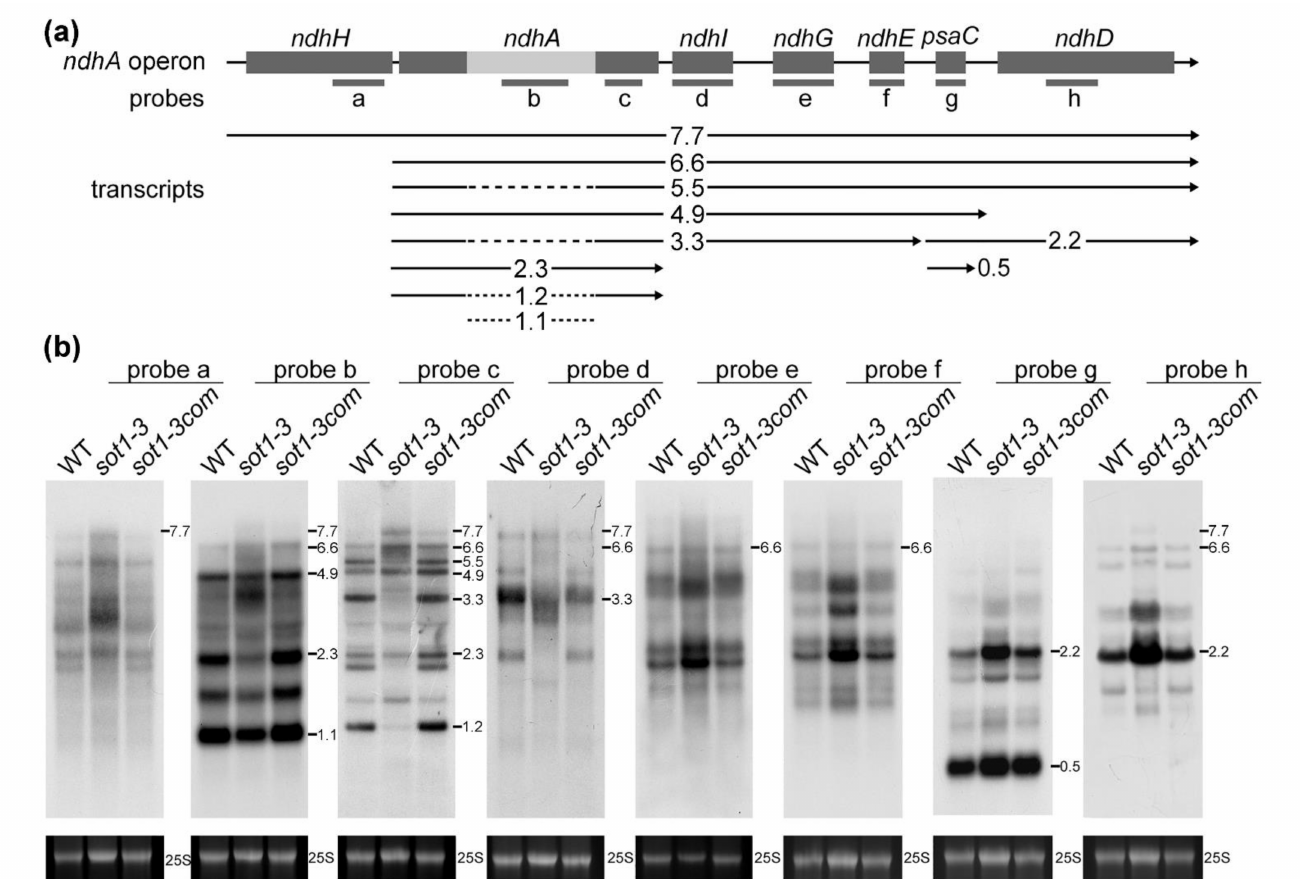
Figure 2. Analysis of transcripts from the ndhA operon in the sot1-3 mutant. ( a ) Schematic illustration of the Arabidopsis ndhA operon. ndhH , ndhA , ndhI , ndhG , ndhE , psaC , and ndhD are cotranscribed from the ndhA operon. The position of each transcript is diagrammed below the operon model, annotated with its length in kilonucleotides. Spliced transcripts are illustrated with a dashed line in the place of the ndhA intron. Probes a to h are shown below the operon model. ( b ) RNA gel blot analysis of transcripts from the ndhA operon. Ten micrograms of total leaf RNA isolated from 12-day-old wild-type (WT), sot1-3 , and sot1-3 com plants was analyzed using an RNA gel blot hybridization. The transcript size is shown in kilonucleotides to the left of each panel. An ethidium bromide staining of the 25S rRNA is shown below each blot as a loading